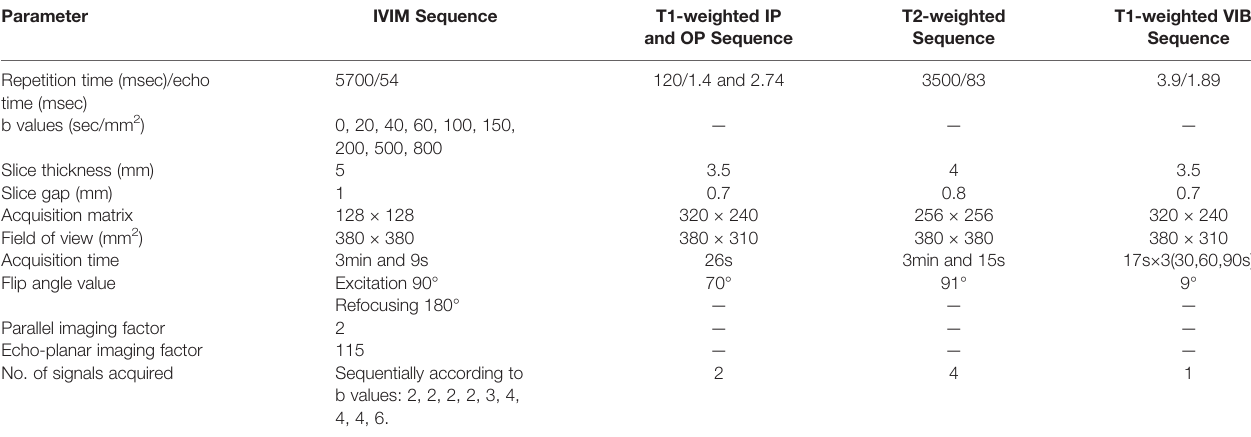
TABLE 1 | IVIM and routine sequence parameters.